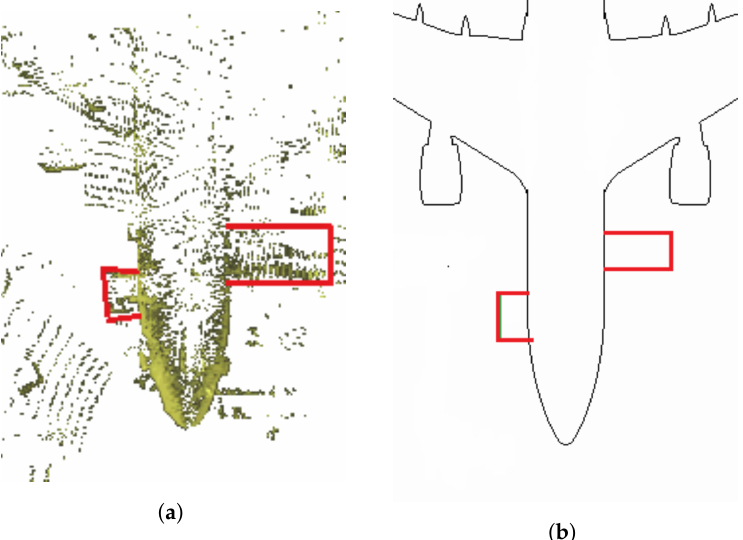
Figure 17. Map update, stairs (red). ( a ) 3D Laser scan real data. ( b ) New occupancy grip